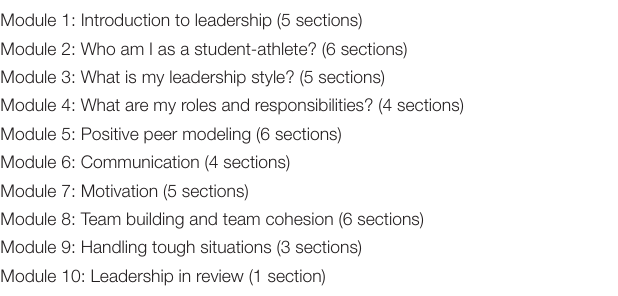
TABLE 1 | Summary of NFHS course